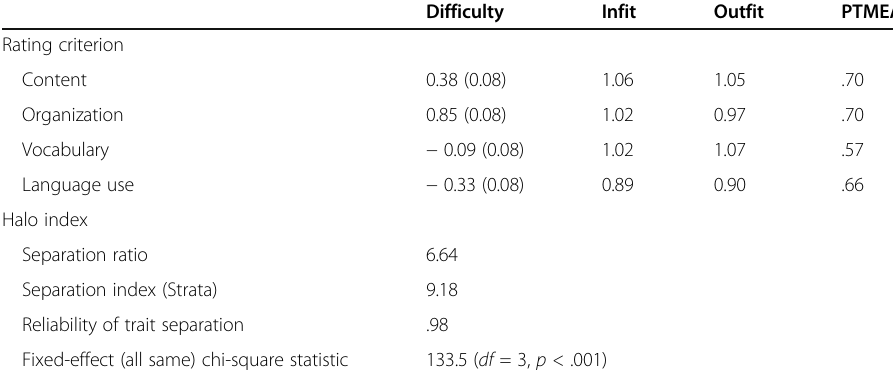
Table 4 Rasch summary statistics of expert